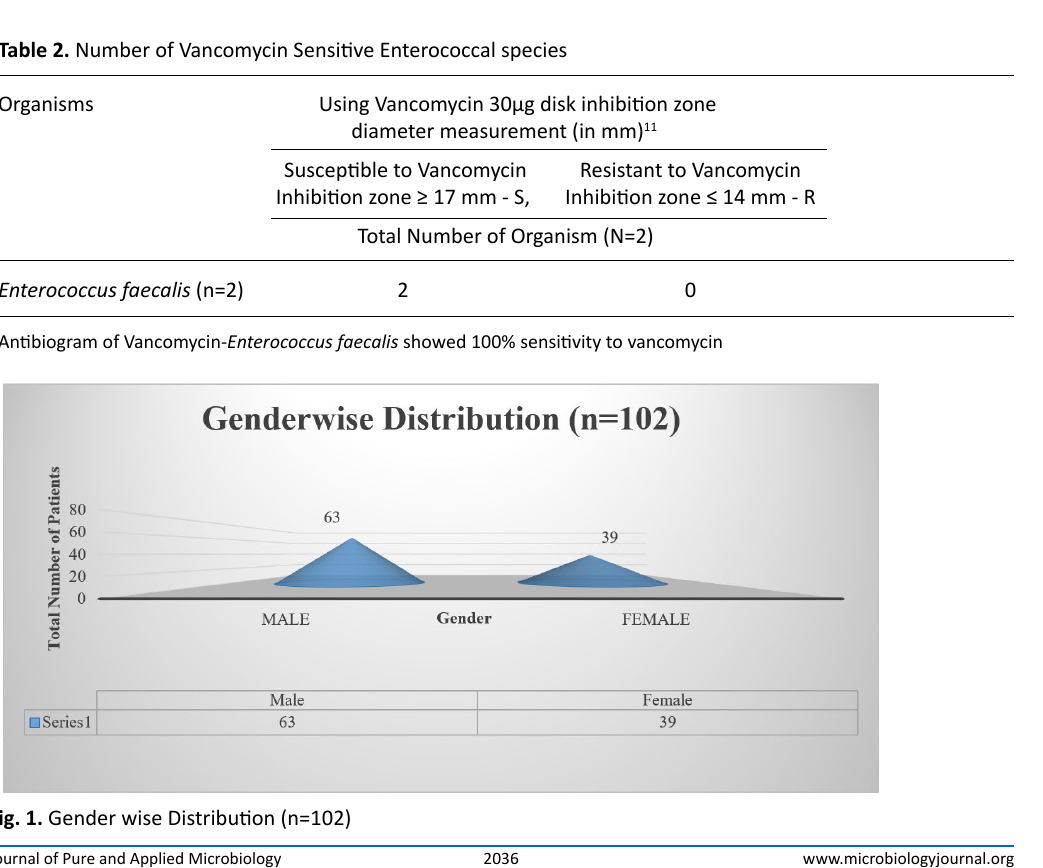
CLSI guidelines11 (Table: 1, Table: 2, Table: 3)